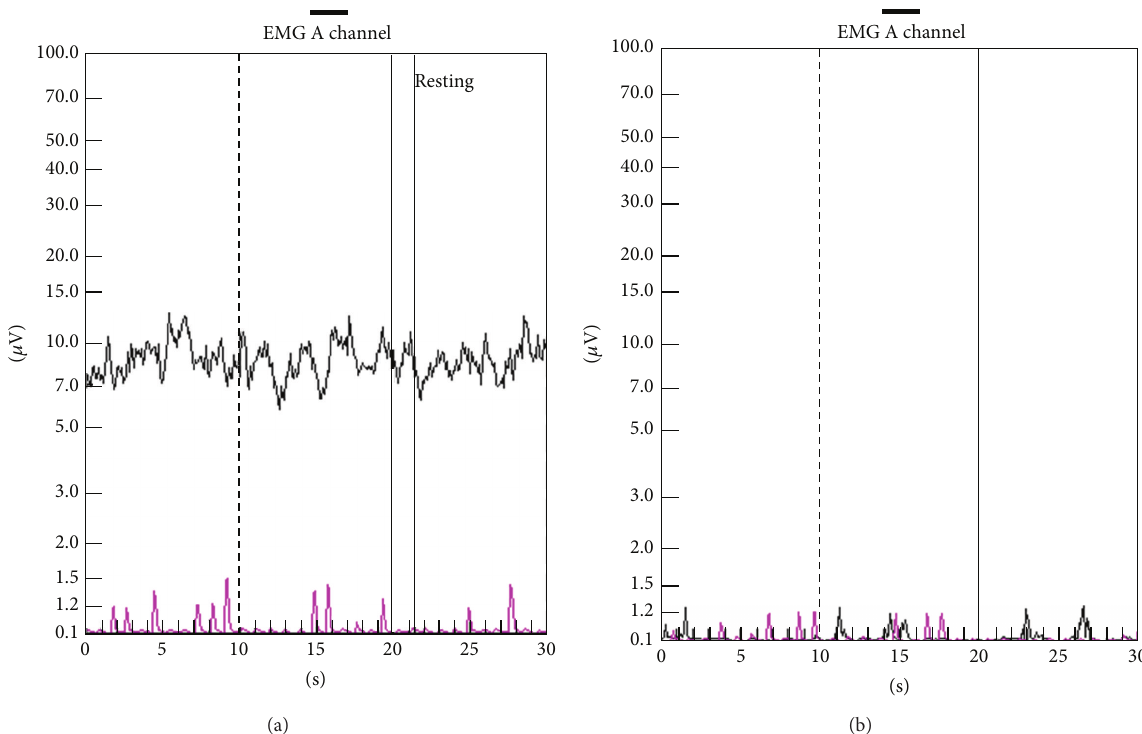
Figure 5: Down-training. (a) Electromyographic tracing of a patient with chronic pelvic pain due to pelvic floor muscle spasm revealing elevated resting tone. (b) Same patient of (a): following 8 sessions of pelvic muscle rehabilitation, the resting muscle tone and symptoms decreased substantially.